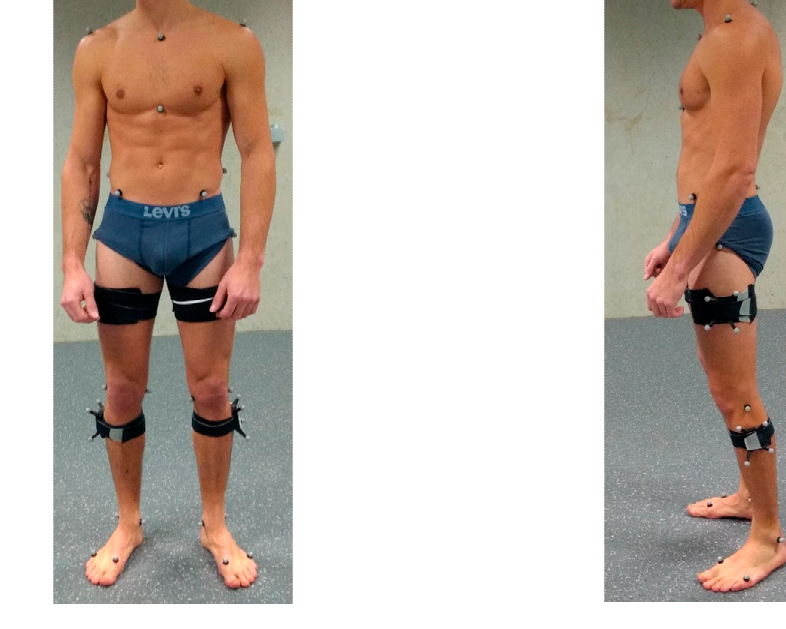
Figure 2. Marker